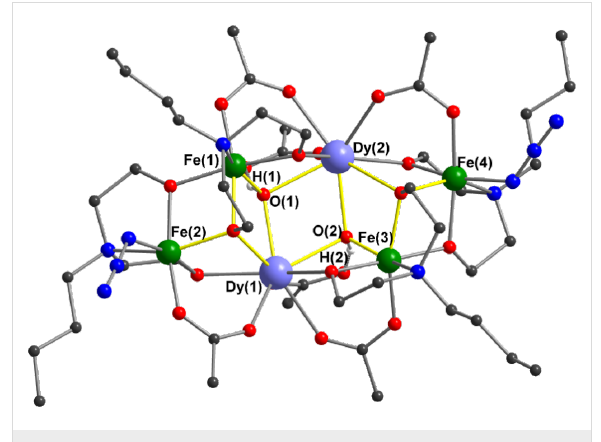
Figure 1: Molecular structure of [Fe 4 Dy 2 (OH) 2 ( N - nbdea) 4 ((CH 3 ) 3 CCOO) 6 (N 3 ) 2 ] and its core. Solvent molecules, disor- dered atoms and organic H atoms have been omitted for clarity. Dy blue; Fe green; O red; N blue; C black, H white.